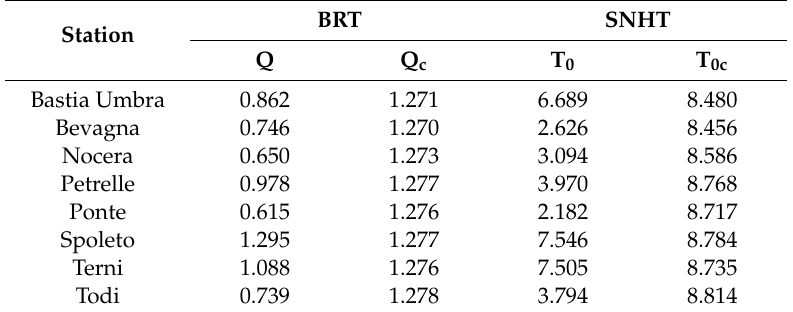
Table 2. Results obtained for the parametric Buishand range (BR) and Standard Normal Homogeneity (SNH) tests; the statistics Q and T 0 and their critical values Q c and T 0c are also shown. BRT SNHT Station